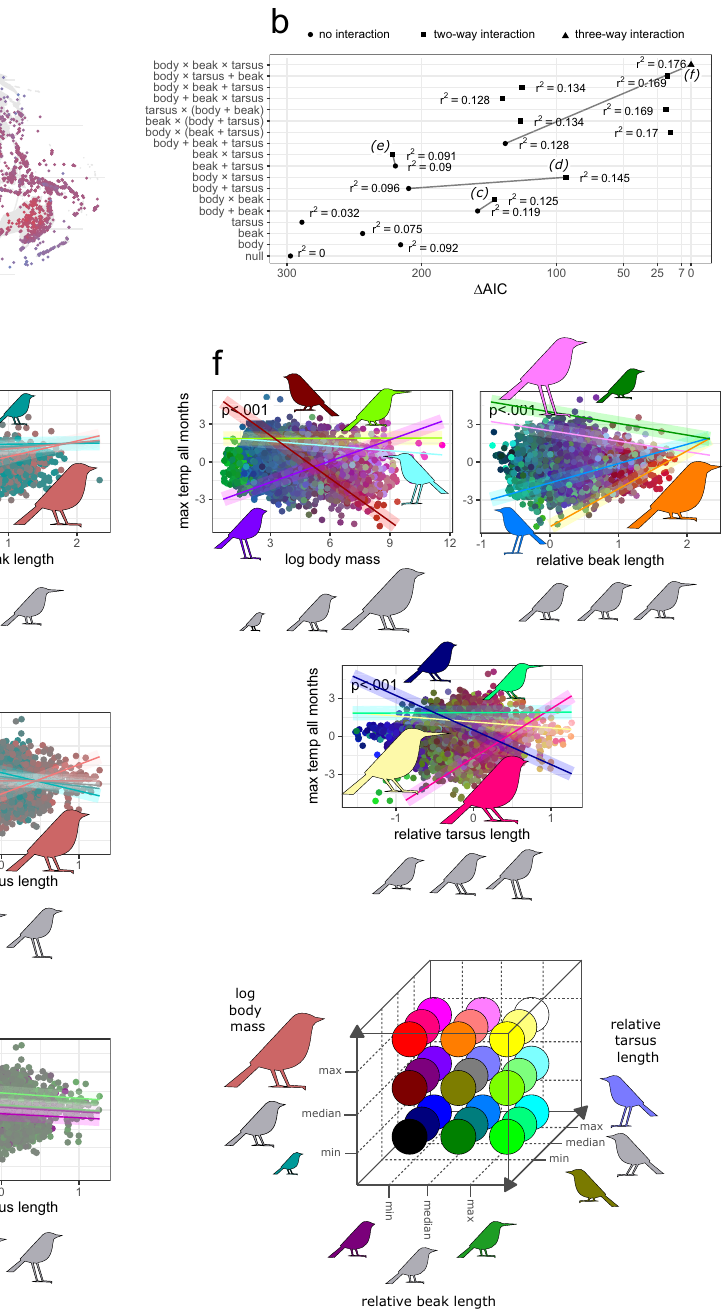
length ( e ) illustrates how Allen ’ s rule based on the relative length of one appendage operates across steeping quantiles of the relative length of second appendage. An exemplar model with three-way interaction of log body mass, relative beak and tarsus length ( f ) illustrates how shifts in body size and two measures of body shape depend on each other when animals adapt to novel climates; the trend lines indicate relationships between y and x 1 (axes) across combinations of min and max values of x 2 and x 3 (colors); see also Supple- mentaryFig. 5formore detailed visualizationof themodel f . The p valuesrefer to signi fi cance of two-way ( c – e ) and three-way ( f ) interaction terms derived from two-tailed tests. The shaded area around the trend line is simple shading to facilitate reading. Obtained with phylogenetic linear regression by phylolm models on a single maximum clade credibility phylogenetic